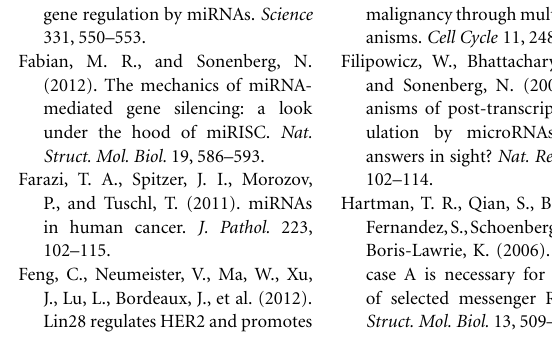
or most Lin28 targets are also targets of miRNA inhibition (see